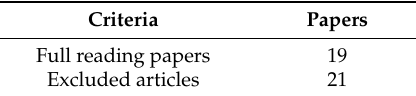
Table 5. Full reading papers included.